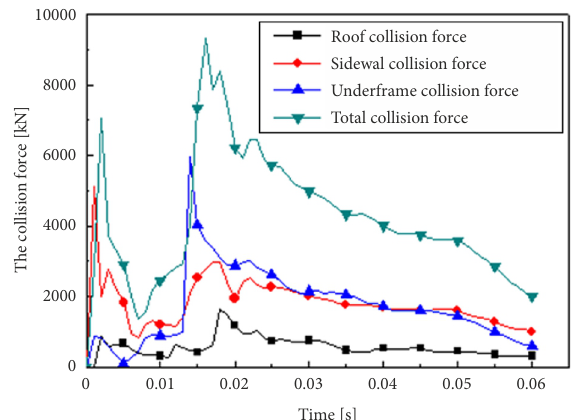
Figure 9. Speed change of gravity center of the vehicle